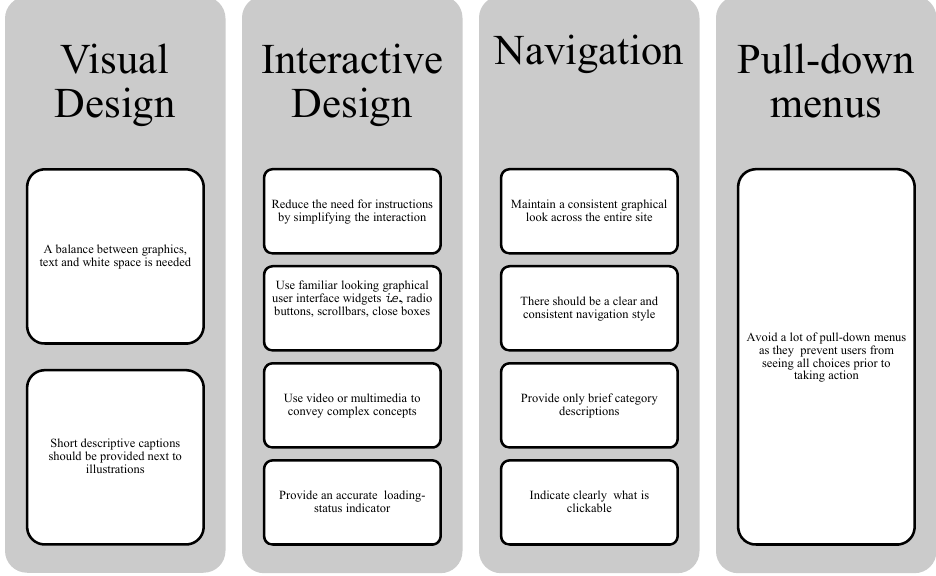
Figure 2. Key requirements to be considered in website design identified from the literature